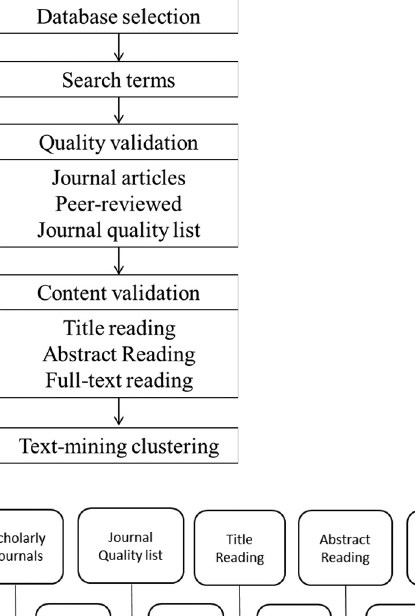
Figure 2. SLR aggregated search outcome